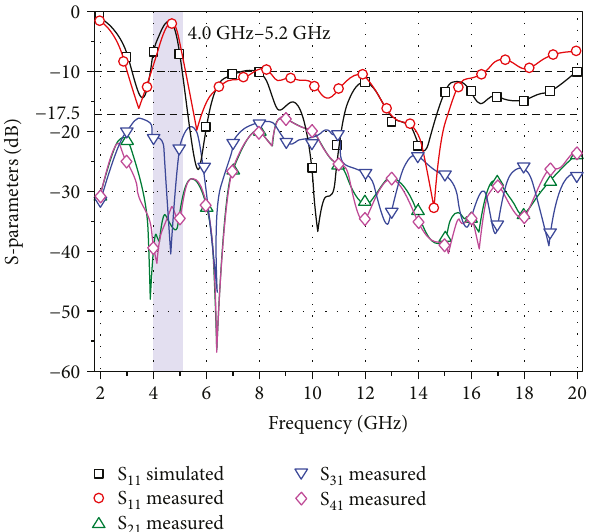
Figure 7: The measured and simulated S-parameters of the fabricated four port MIMO